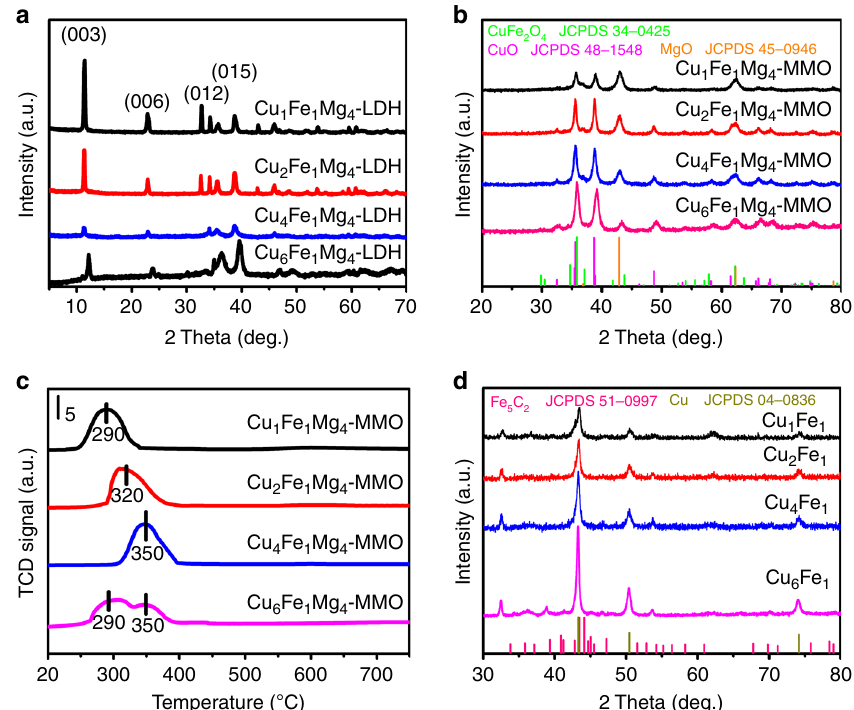
Fig. 1 Catalysts characterizations. a XRD patterns of Cu x Fe y Mg 4 – LDH precursors with three molar ratios of Cu/Fe (1:1, 2:1, 4:1, and 6:1, respectively). b XRD patterns of Cu x Fe y Mg 4 – MMO calcined samples obtained from calcination of LDHs precursors. c H 2 -TPR pro fi les of Cu x Fe y Mg 4 – MMO samples. d XRD patterns of Cu x Fe y obtained from activation of MMO samples in syngas (25% CO + 25% H 2 + 50% CO 2 ) under optimum conditions (300 °C (2 h) + 350 °C (1 h); rate: 2 °C min − 1 ) and passivation.